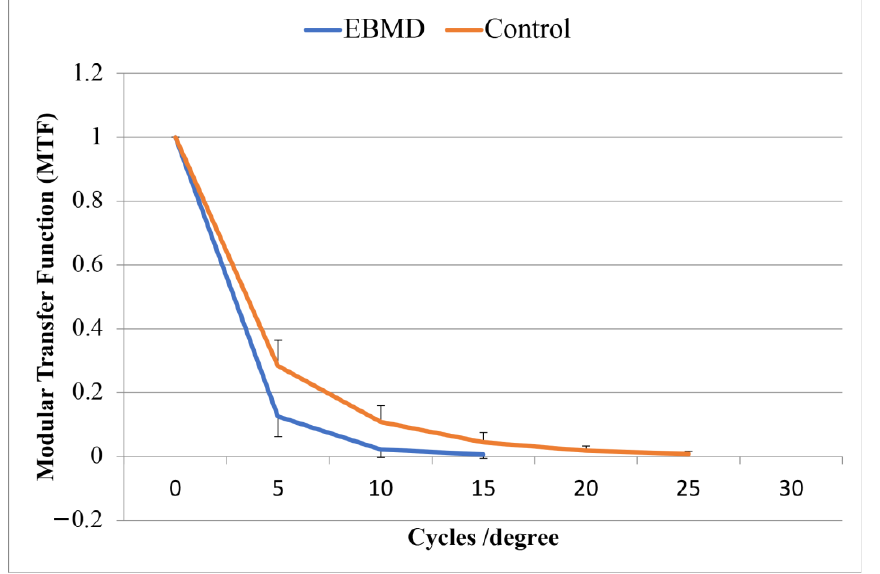
Figure 4. The Modular Transfer Function (MTF) cut-off for the two groups was averagely lower in the case group than in the control group.